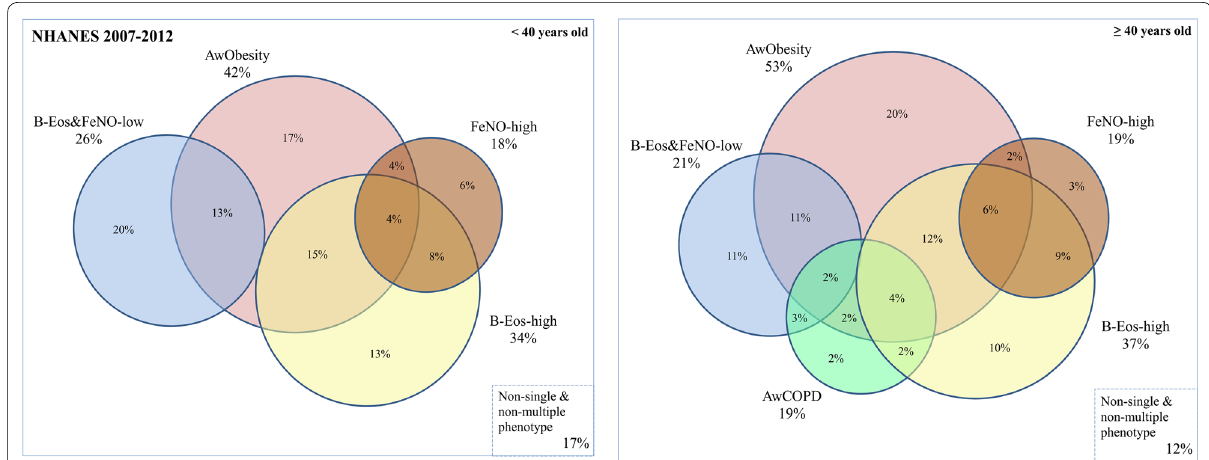
Fig. 2 Venn-Euler diagrams quantifying the overlap among the asthma phenotypes, stratified by age. Data presented in weighted percentages to the US population. The overlap between AwCOPD with FeNO-high asthma (0.1%) and the overlap between AwCOPD, FeNO-high, AwObesity and B-Eos-high (0.5%) phenotypes are not